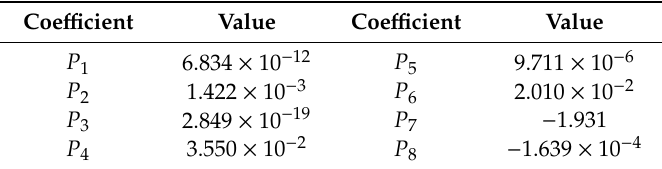
Table 2. Coe ffi cients of the initiation time